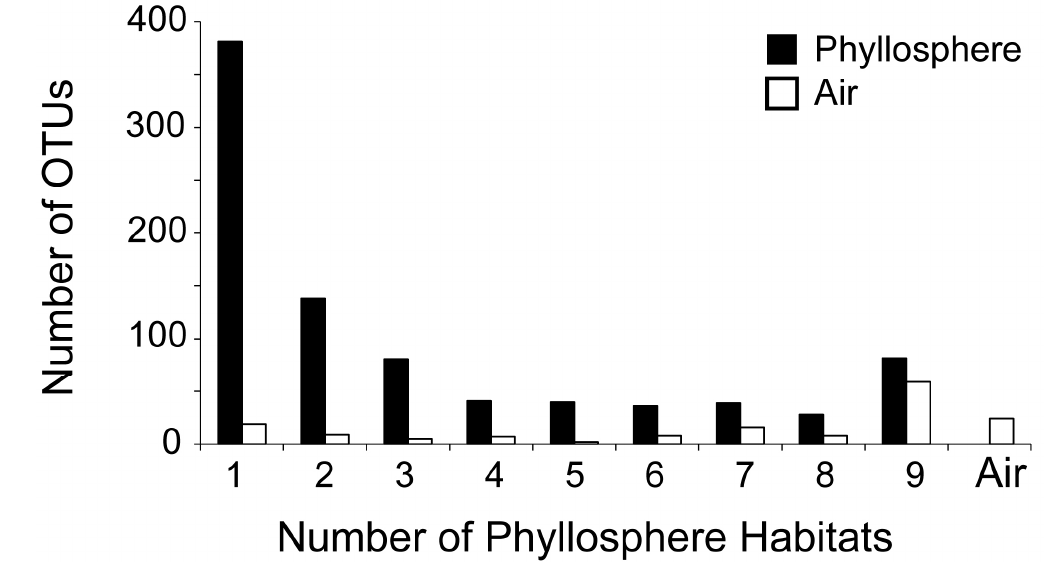
Figure 2. Number of bacterial OTUs in the phyllosphere of a Mediterranean ecosystem that were detected in only one up to all nine phyllosphere habitats (species) that were sampled, and number of these OTUs that were also found in the air; the final bar marked as ‘Air’ corresponds to the OTUs that were not detected in any phyllosphere habitat but only in the air. Numbers are determined from the entire dataset, with summer and winter data combined.